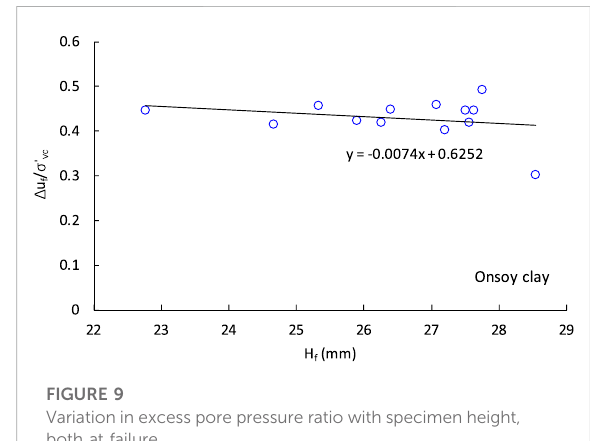
FIGURE 8 Excess pore pressure ratio plotted against shear strain at a shearing rate of 2.5 mm/min.